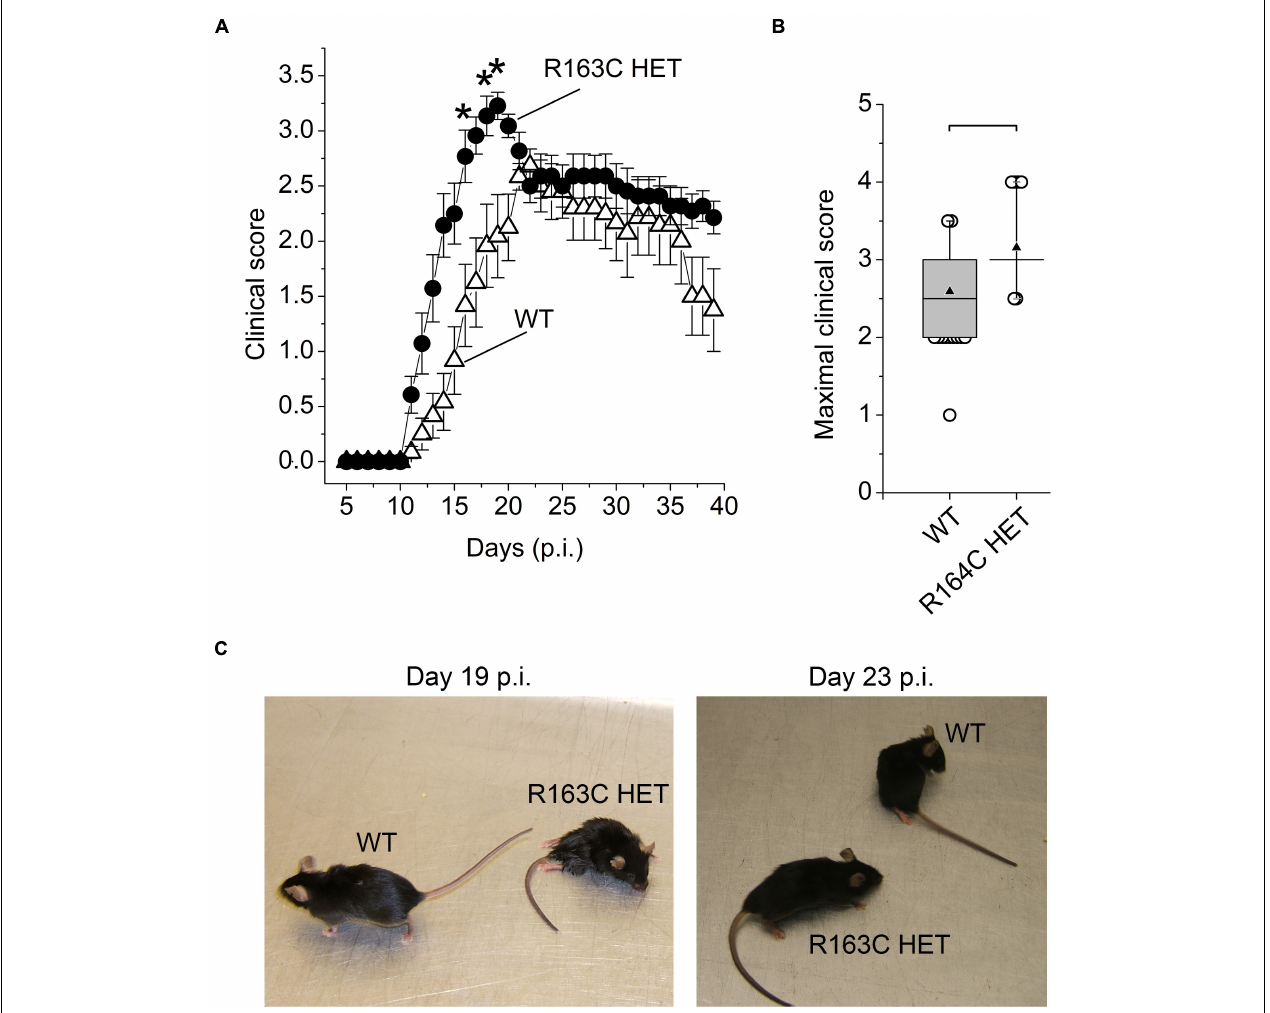
FIGURE 3 | A RyR1 gain-of-function mutation accelerates development of EAE symptoms. (A) Cumulative clinical scores in WT (open circles; n = 12) and R163C HET (black circles; n = 12) mice. n, number of animals in the group. EAE was induced in both groups of mice on the same day (day 0). Asterisks (*) denote significant differences between mean scores in WT and R163C HET groups (two-way repeated-measures ANOVA with Bonferroni correction; p < 0.05). Combined data from two experiments (6 mice per group in each experiment) shown as mean ± SE. (B) Box charts of maximal clinical scores recorded from the day 14 p.i. until day 16 p.i. in R163C HET group ( n = 33) and from day 21 to day 23 in WT group ( n = 33). n, number of measurements in each group. Data are from the same groups shown in (A) . Brackets indicate that differences between means are significant ( p < 0.01; independent Student’s t -test). In the box charts, the boundary of the box closest to zero indicates the 25th percentile, a horizontal line within the box marks the median, a black up-pointing triangle within the box marks the mean, and the boundary of the box farthest from zero indicates the 75th percentile. Whiskers above and below the box indicate the 5th and 95th percentiles. Open circles above and below the whiskers indicate outliers outside the 5th and 95th percentiles. (C) Images of representative WT and R163C HET littermate mice at day 19 p.i. and day 23 p.i. On day 19 p.i., the clinical scores were 0.5 and 4 for WT and R163C mice, respectively; on day 23 p.i. the clinical scores were 2.5 and 3.5 for WT and R163C HET mice,